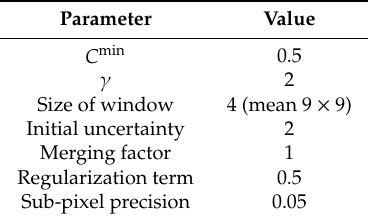
Table 1. Correlation parameters for calculating coseismic